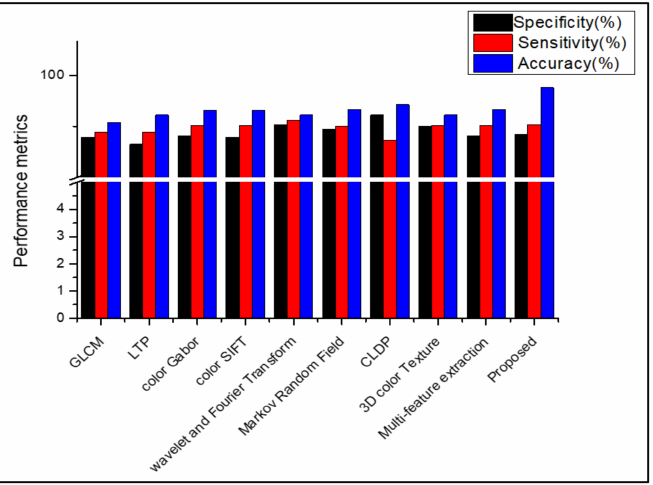
Figure 12. Comparison of performance using various features in